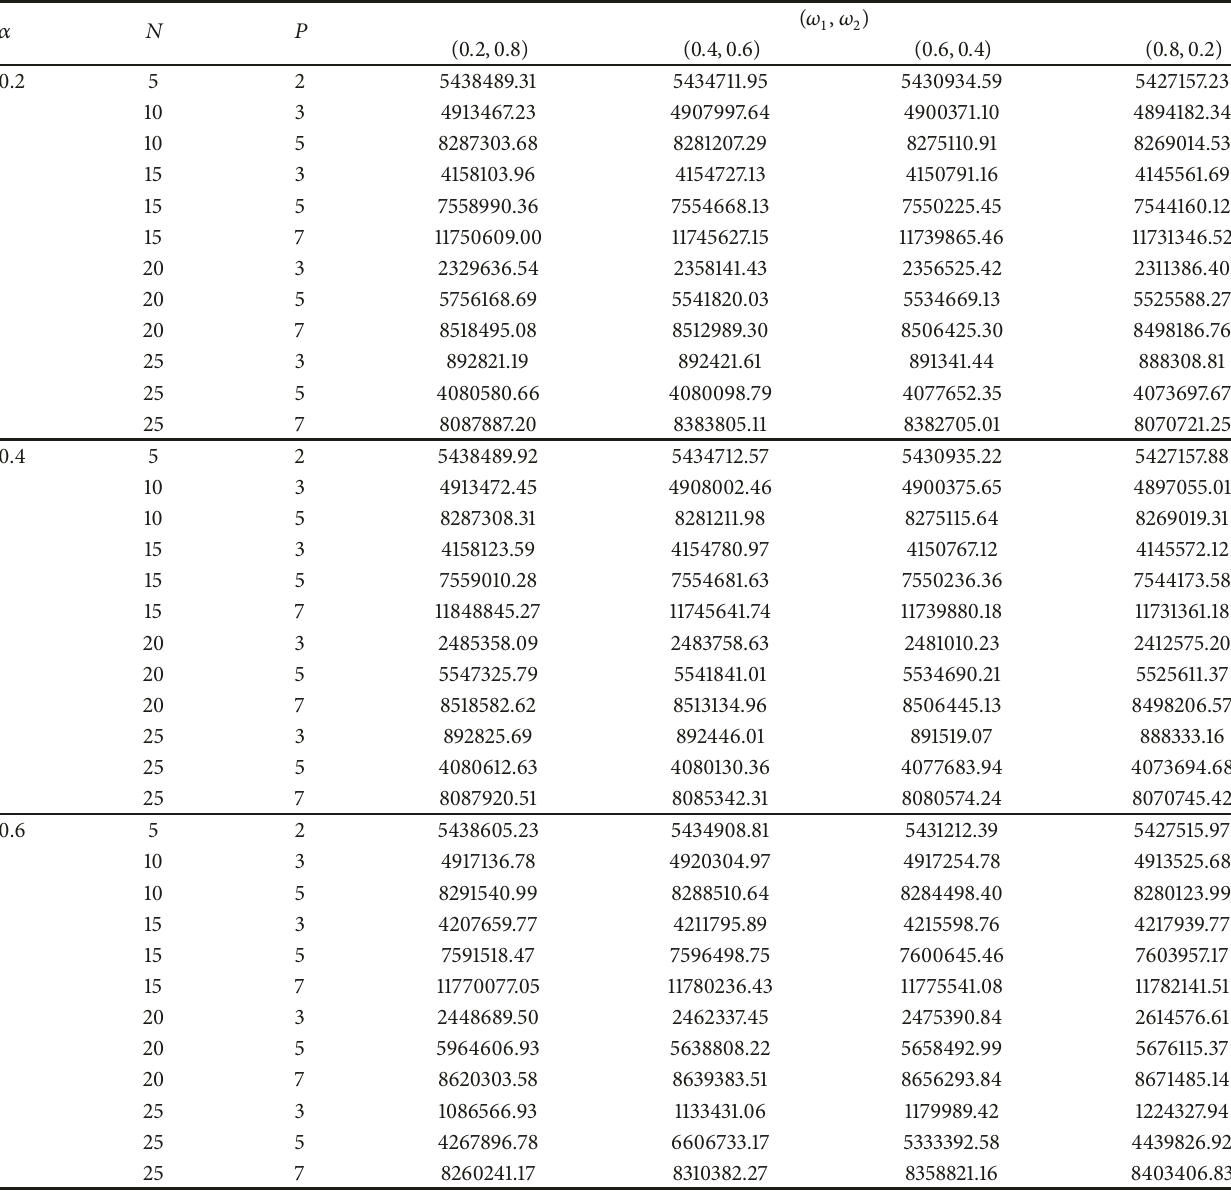
Table 2: Profits under mixed weight